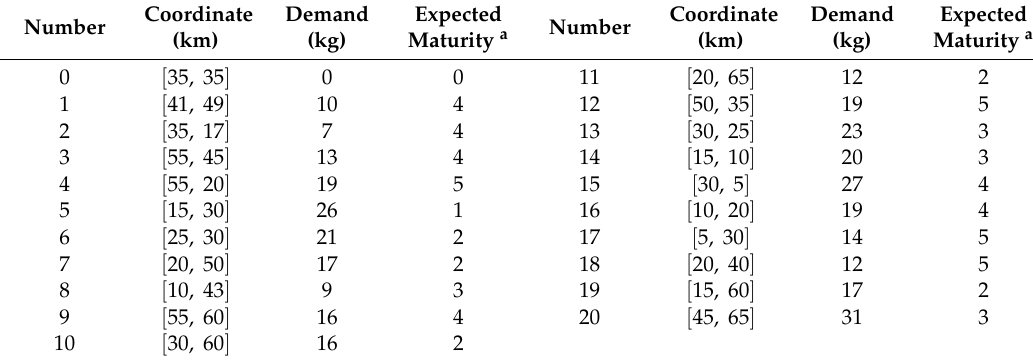
Table 4. Consumer order information.